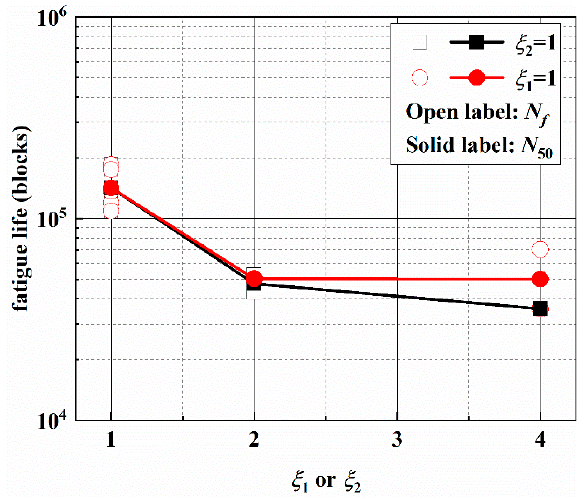
Figure 3. Frequency ratios effect on multiaxial fatigue life.